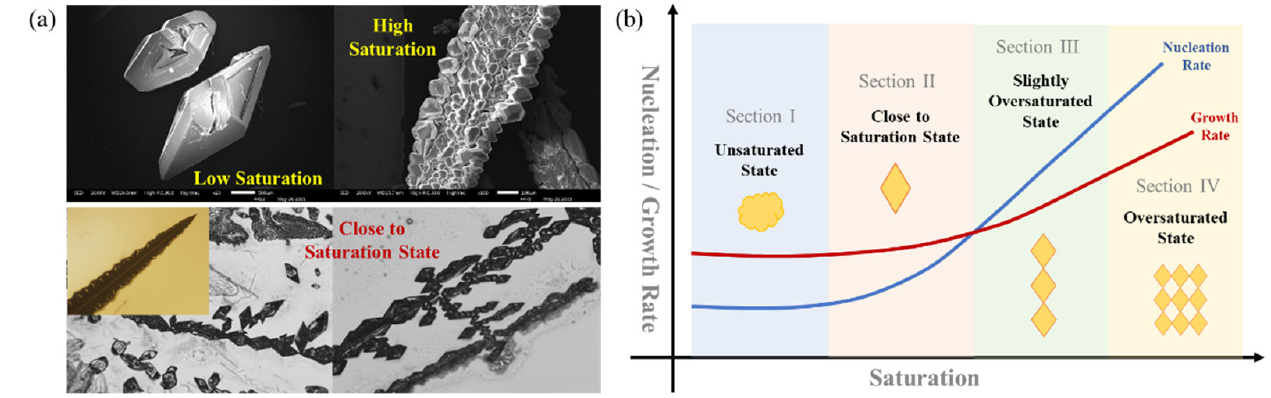
Figure 4. Growth process of sulfur crystals in toluene with different saturations ( a ) and speculation of possible growth mechanism ( b ).